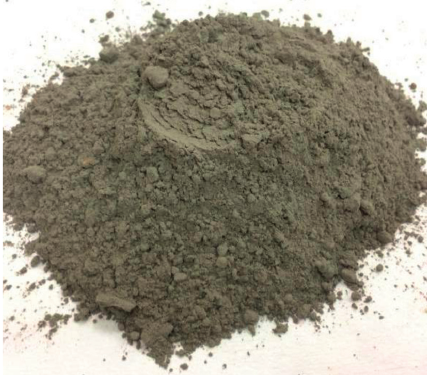
Figure 3: Portland cement. Table 2: Chemical composition of the cement.